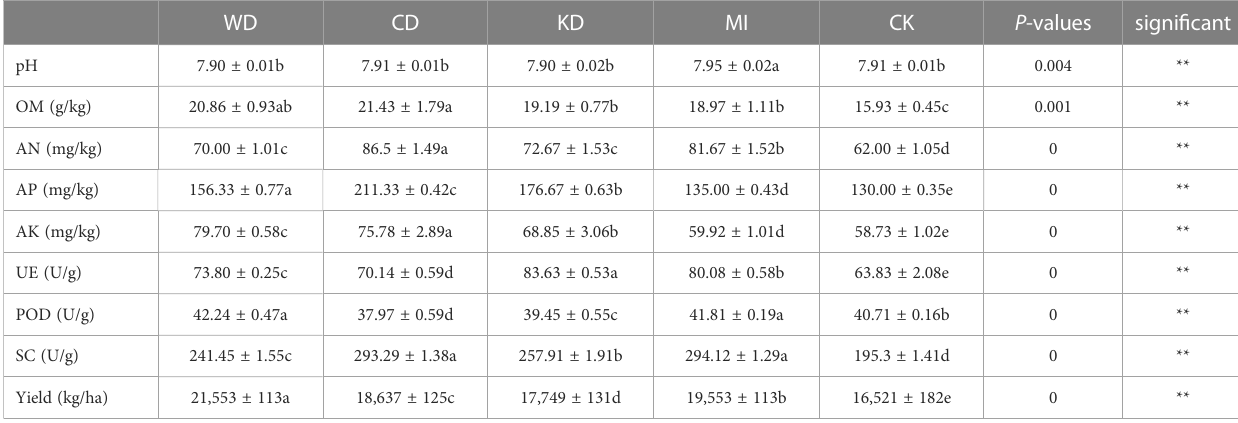
TABLE 1 Chemical properties and enzymatic activities of